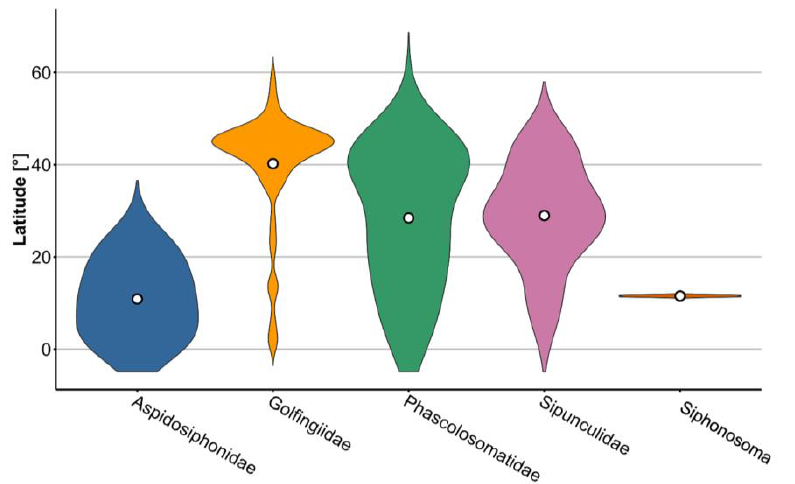
Figure 5. Violin plot representing the latitudinal distribution of Sipuncula records for five families across the Northwest Pacific. All plots have the same maximum width making comparisons of density across the families impossible. The white dots indicate the median.